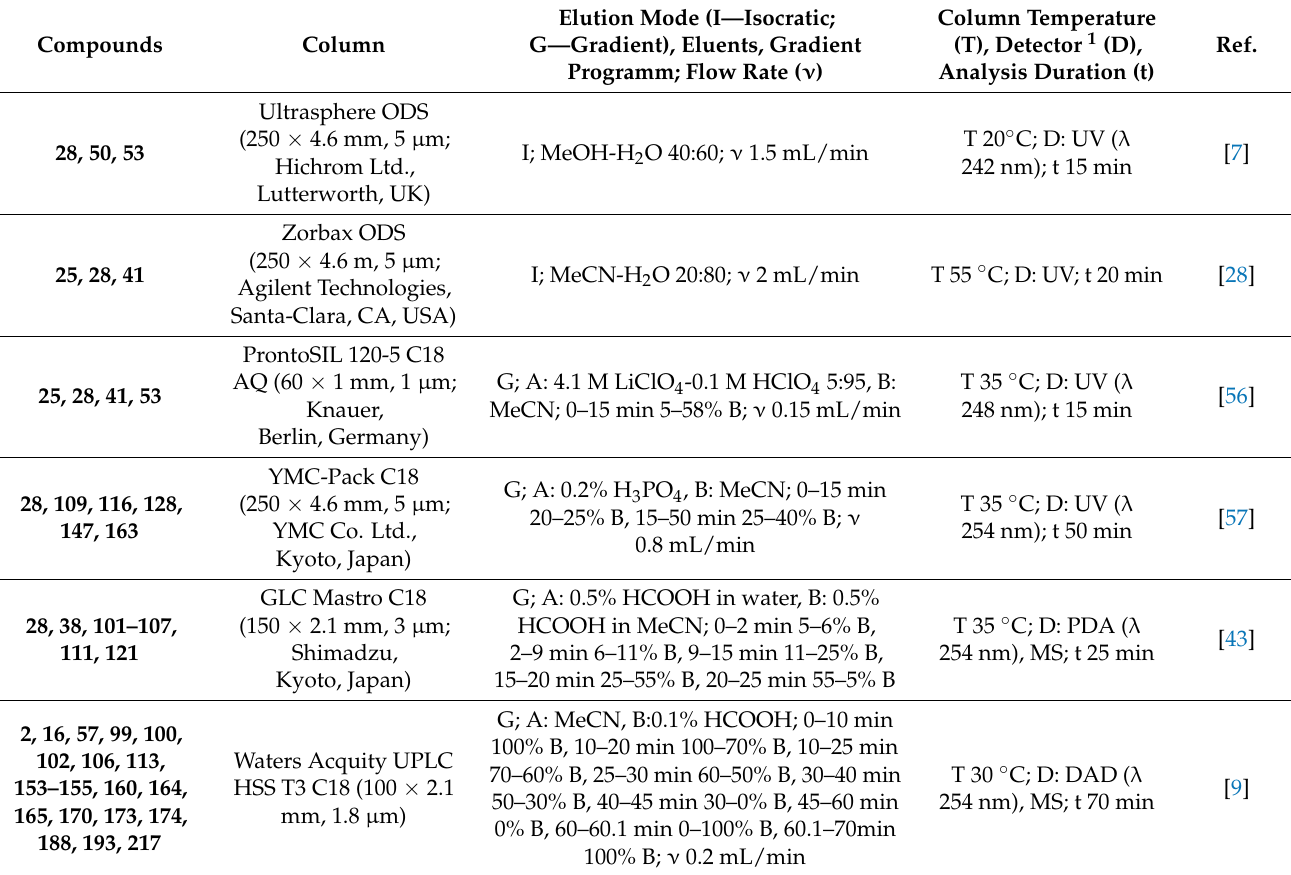
Table 3. HPLC analysis conditions used for the separation of selected R. uniflorum metabolites.